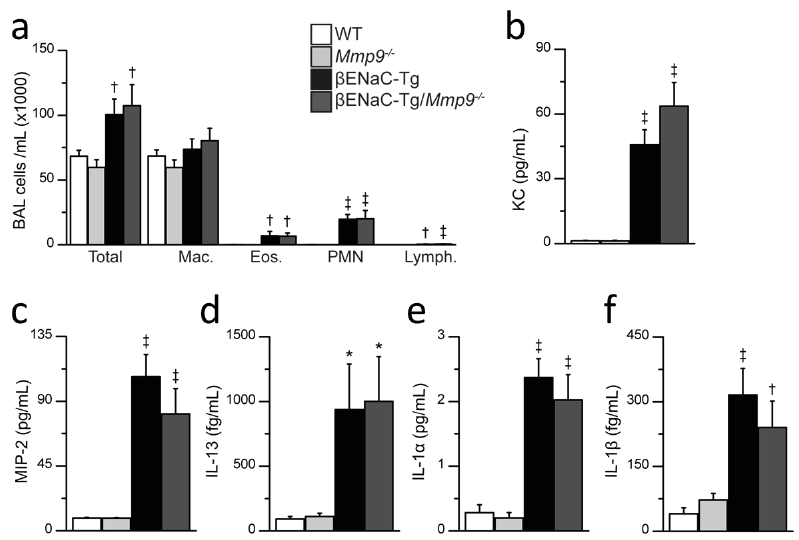
Figure 3. Genetic deletion of Mmp9 does not reduce airway inflammation in β ENaC ‐ Tg mice. ( a – f ) Inflammatory cell counts ( a ) and cytokine levels ( b – f ) in BAL fluid of 6–8 ‐ week ‐ old WT, Mmp9 ‐ / ‐ , β ENaC ‐ Tg and β ENaC ‐ Tg/ Mmp9 ‐ / ‐ mice. ( a ) Total and differential cell counts of bronchoalveolar macrophages (Mac.), eosinophils (Eos.), neutrophils (PMN) and lymphocyte (Lymph.) in BAL fluid. † p < 0.01 compared to WT or Mmp9 ‐ / ‐ , ‡ p < 0.001 compared to WT or Mmp9 ‐ / ‐ , n = 12–30 mice per group. ( b – f ) Levels of the pro ‐ inflammatory cytokines keratinocyte chemoattractant (KC) ( b ), macrophage inflammatory protein 2 (MIP ‐ 2) ( c ), IL ‐ 13 ( d ) IL ‐ 1 α ( e ) and IL ‐ 1 β ( f ) in BAL supernatant. * p < 0.05 compared to WT or Mmp9 ‐ / ‐ , † p < 0.01 compared to WT or Mmp9 ‐ / ‐ , ‡ p < 0.001 compared to WT or Mmp9 ‐ / ‐ , n = 10 mice per group. Statistical analysis was performed with one ‐ way ANOVA.